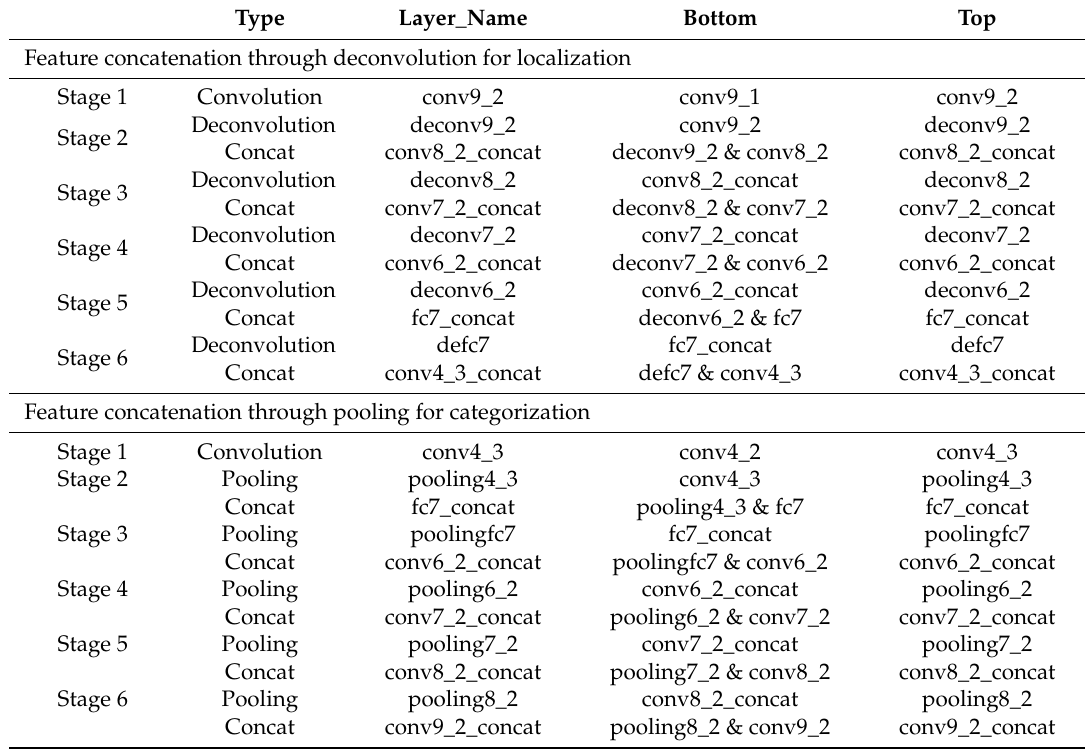
Table 1. Network architectures of the feature concatenation through deconvolution and pooling. Type Layer_Name Bottom